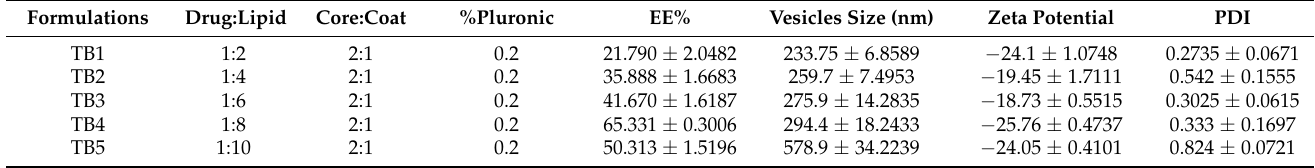
Table 1. The composition of different trial batches of QTF loaded lipospheres with their responses. Formulations